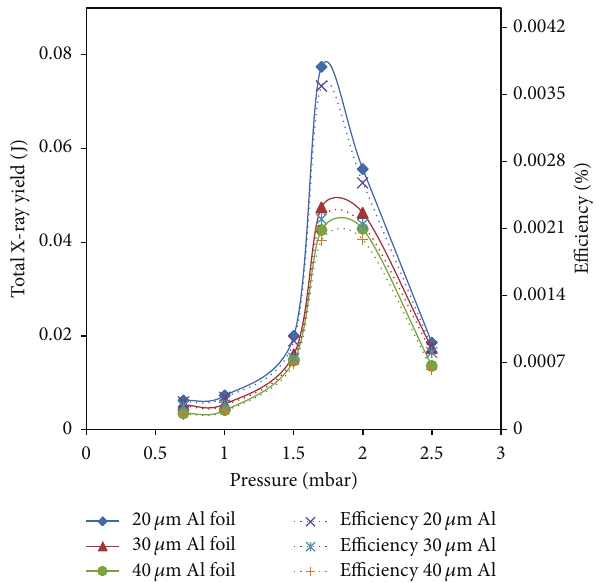
Figure 7: Variation of total X-ray yield in 4 𝜋 -geometry with efficiency versus Argon gas pressure at constant applied voltage 12